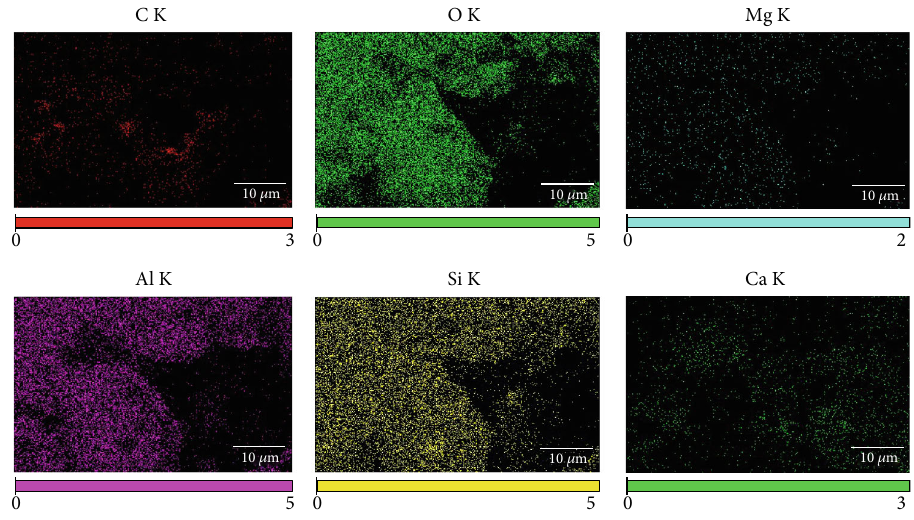
Figure 10: Distribution of element analysis.